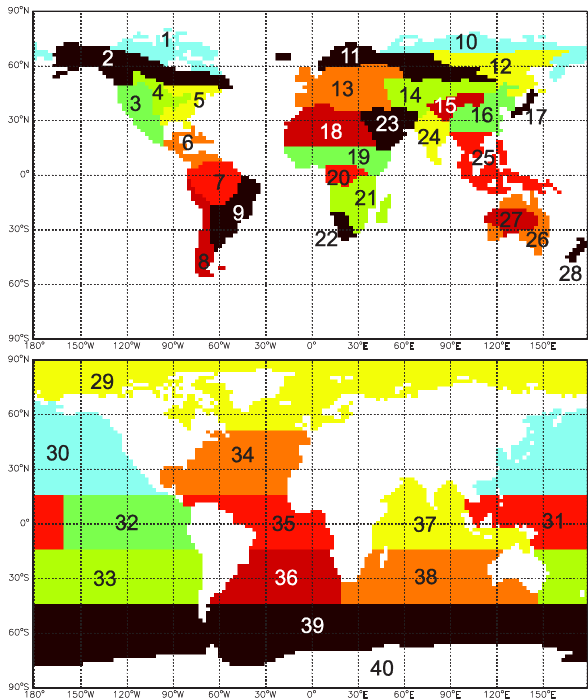
Fig. 15. The 40 regions used in our inversions are defined as the standard 11 TransCom 3 ocean regions, 28 land regions based on AVHRR definitions of dominant vegetative types, and the Rest of the World (ROW) consisting of mostly Antarctic/Greenland and some small isolated islands. Coastal grid boxes can belong to both land and ocean